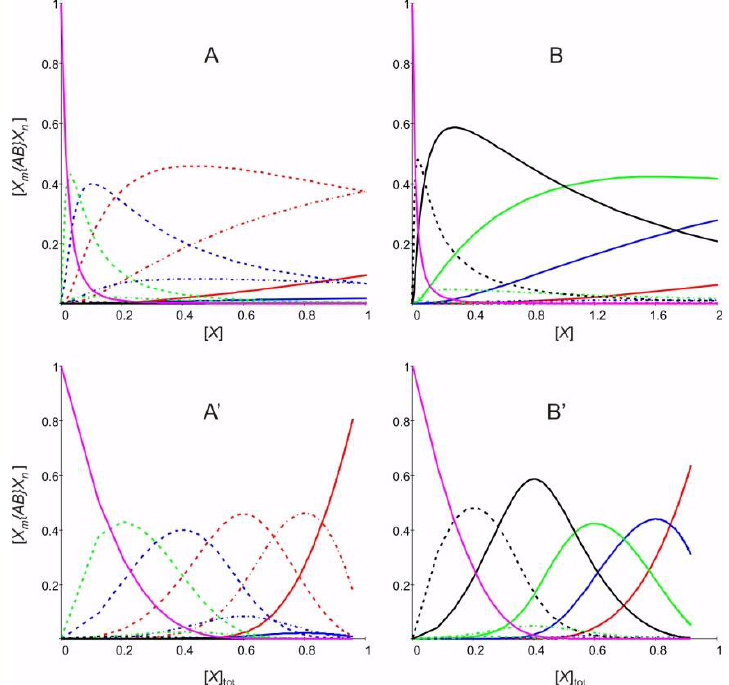
Figure 1. Concentration of X m { AB } X n as a function of the concentration of X , ( A , B ), and versus the total concentration [ X ] tot of X in the system, ( A’ , B’ ). ( A , A’ ) calculated for K 1 = 50.0 and K 10 = 1.0; ( B , B’ ) calculated for K 1 = 1.0 and K 10 = 50.0. Red lines: [ X 3 { AB } X n ] (solid: n = 2, dash: n = 1, dash dot: n = 0). Blue lines: [ X 2 { AB } X n ] (solid: n = 2, dash: n = 1, dash dot: n = 0). Green lines: [ X { AB } X n ] (solid: n = 2, dash: n = 1, dash dot: n = 0). Black lines: [{ AB } X 2 ] solid: [{ AB } X ] dash. Pink line: [{ AB }] = C 12